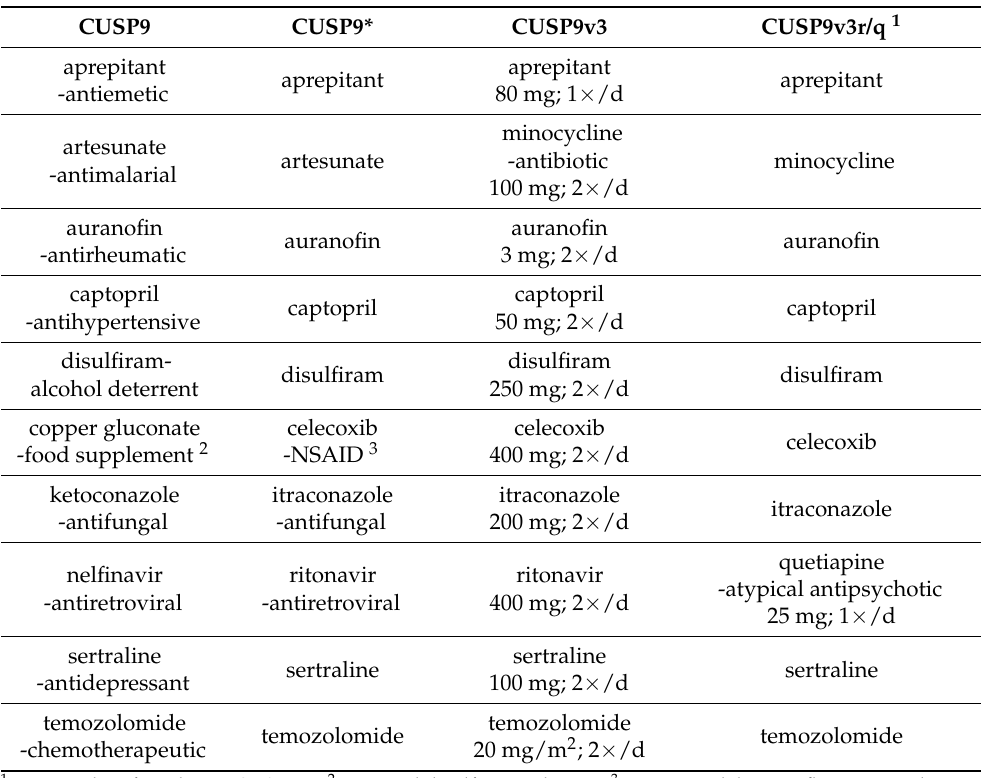
Table 1. Evolution of the different CUSP9